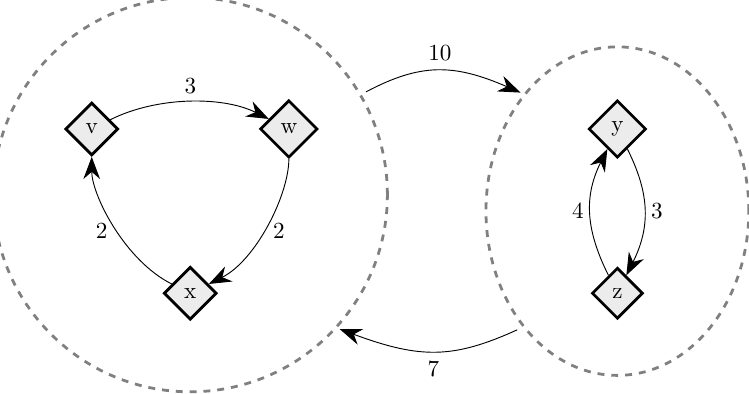
Figure 16. Cyclic decomposition. The unperturbed dynamic converges to conventions in the set v , w , x , y , z . A directed edge from a convention corresponds to a least cost transition from this { } convention as per Figure 15. This decomposes the set of conventions into two sets, Transition costs between these two sets are determined as described in the main